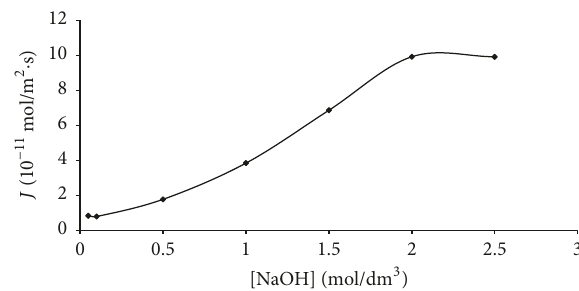
Figure 7: Effect of NaOH concentration in strip solution on the flux of Zn (II). [NaOH] in stripping solution 0.05 mol/dm 3 to 2.5 mol/dm 3 , [HCl] in feed solution = 2.0 mol/dm 3 , [TDDA] in membrane phase = 0.80 mol/dm 3 , time = 5.0